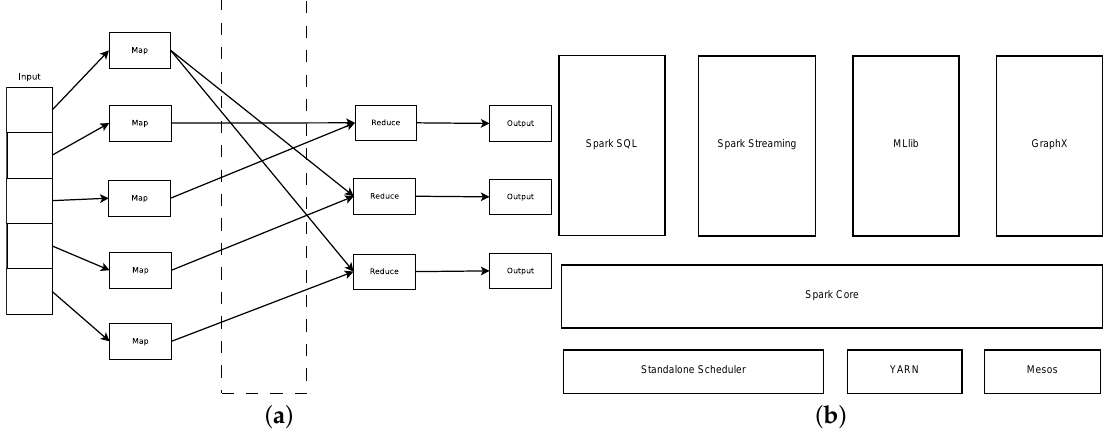
Figure 1. Distributed frameworks. ( a ) Architecture of MapReduce model; ( b ) The Spark stack.